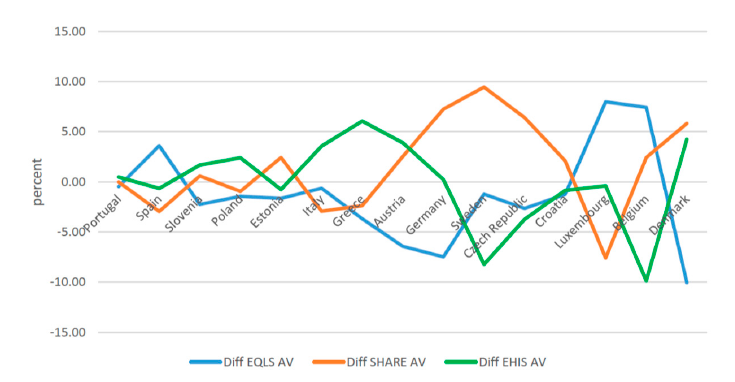
Figure 4. Di ff erence between Informal Caregivers over 50 and average, males (weighted) (percent). EQLS = European Quality of Life Survey; SHARE = Survey of Health, Ageing and Retirement in Europe; EHIS = European Health Interview Survey.